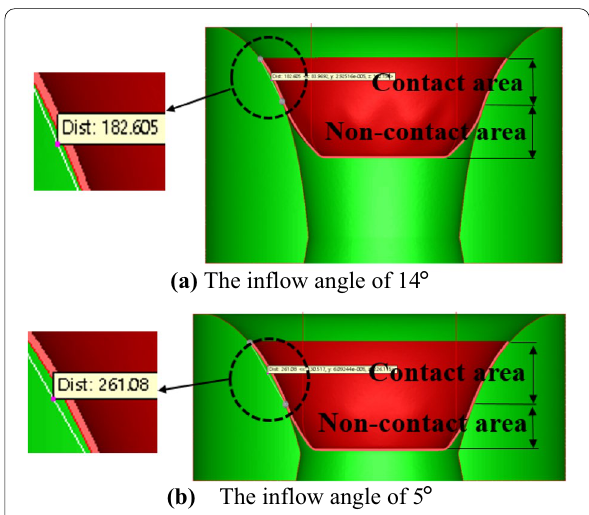
Figure 12 Lengths of the workpiece that contacted the die in cases of inflow angles of 5° and 14°